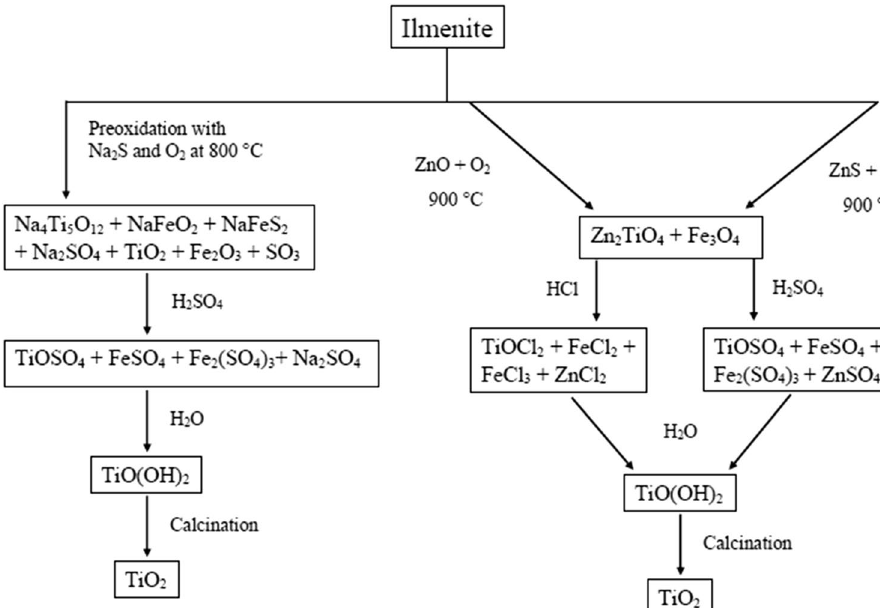
Fig. 7 The flow chart of syn- thesizing